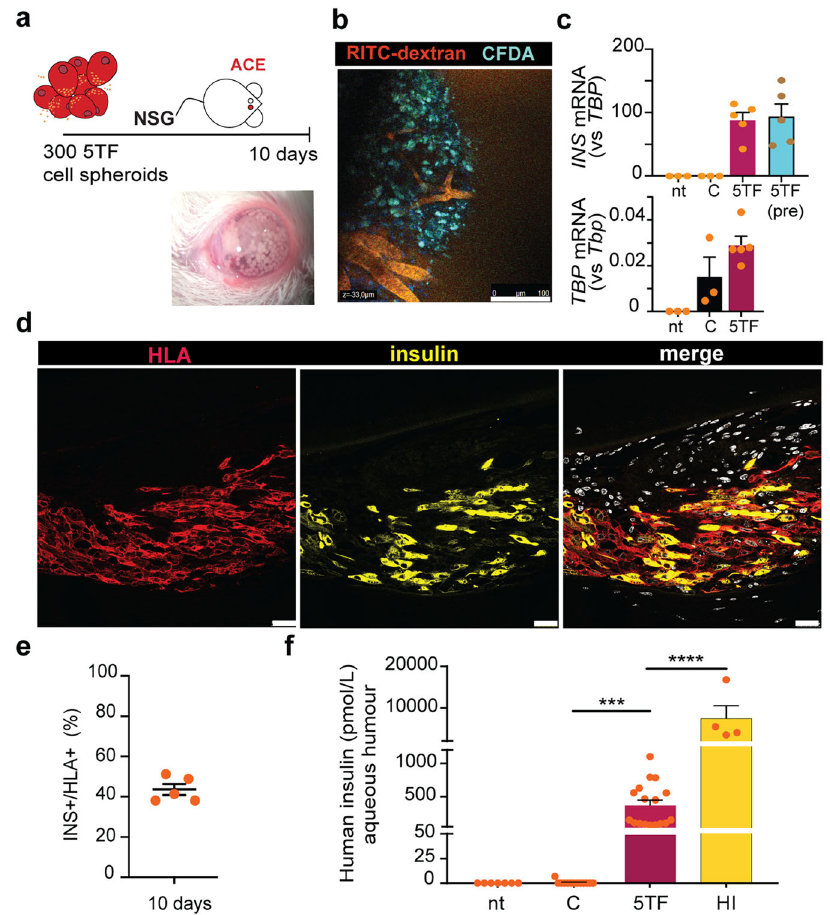
Fig. 7 In vivo characterization of 5TF cell spheroids. a Schematic illustration and image showing 5TF cell spheroids transplanted into the anterior chamber of the eye (ACE) of a normoglycemic NSG mouse. b Vascularization of 5TF cell grafts ten days following transplantation into the ACE. Representative in vivo image depicting functional vessels (RITC-dextran, red) and viable 5TF cells (CFDA, green). Scale bar, 100 μ m. c qPCR of INS and TBP transcripts in eyes of non-transplanted mice (nt, n = 3) and mice transplanted with either control fi broblast spheroids (C, n = 3) or 5TF cell spheroids ( n = 5) collected ten days post-transplantation. INS gene expression in 5TF cell spheroids prior to transplantation is depicted in the blue bar ( n = 6). INS gene expression is calculated relative to TBP . Expression of TBP relative to mouse Tbp is shown to prove the presence of human cells in eyes receiving control and 5TF spheroids. Data are presented as mean ± SEM. d Representative immuno fl uorescence images showing HLA staining in red and insulin staining in green in 5TF cell grafts ten days post-transplantation. Scale bar, 25 μ m. e Percentage of cells doubly positive for insulin and HLA (relative to total HLA + cells) in 5TF cell grafts at day 10 following transplantation. Each dot corresponds to one eye graft ( n = 5). f ELISA determination of human insulin in the aqueous humor in un-transplanted mice ( n = 7), in mice transplanted with either 300 fi broblast spheroids ( n = 14) or 300 5TF cell spheroids ( n = 17) at day 10 post-transplantation and in mice transplanted with 150 – 200 human islets ( n = 4) at day 12 – 15 post-transplantation. Data are presented as mean ± SEM for the number of n indicated in parentheses. *** P < 0.001; *** P < 0.0001 between indicated samples using unpaired t